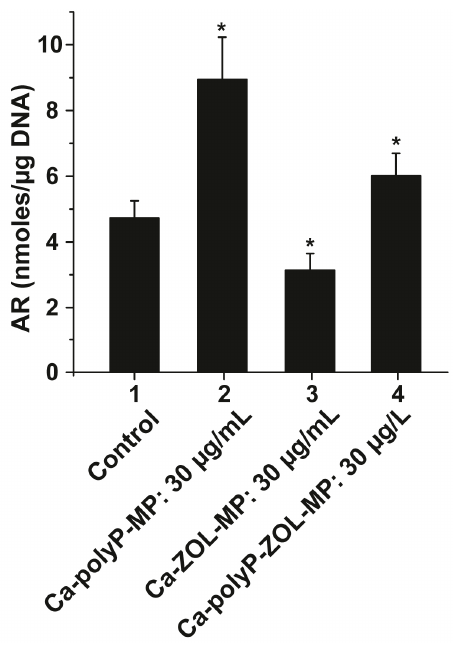
Figure 8. Influence of the particles (30 µ g/mL of “Ca-polyP-MP”, “Ca-ZOL-MP”, or “Ca-polyP-ZOL-MP”) on bone marrow cells present in femurs on the extent of biomineralization during a 5 days incubation in DMEM medium/FBS. After termination of the experiments, the bone marrow cells were carefully removed from the femurs and quantitatively assayed for mineralization with Alizarin Red S. The reintroduced red color is measured at 405 nm applying the spectrophotometric assay. The amount of bound Alizarin Red S is given in nmoles. Values were normalized to 1 μ g of DNA in the samples; The significant differences are indicated with asterisks; * p < 0.01.